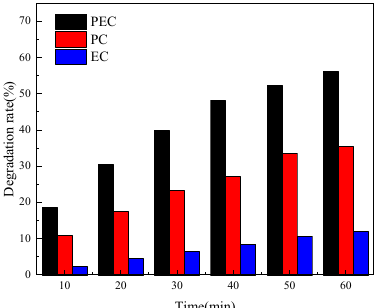
Figure 8. Degradation curves and reaction kinetics of photoelectrocatalysis OTC with different TiO 2 nanotube electrodes.